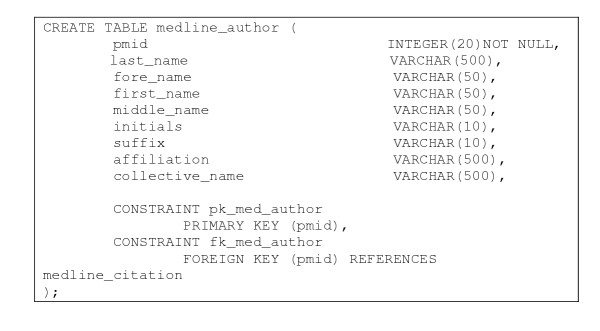
Representation of author information in the database schema. The typical table has a PubMed identifier (pmid) associated with other fields.